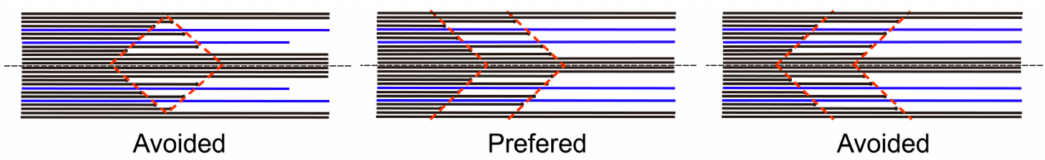
Figure 16. Patterns of the different kinds of transition regions.